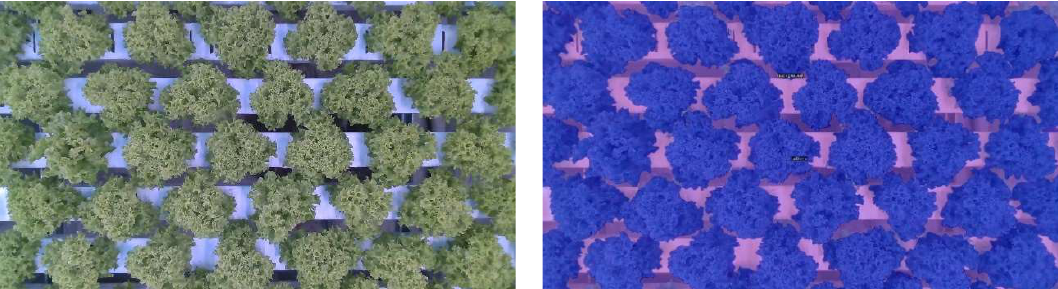
Figure 5. Example of original ( left ) and annotated image ( right ). The annotated image has two classes in blue the lettuce class and pink the background class.